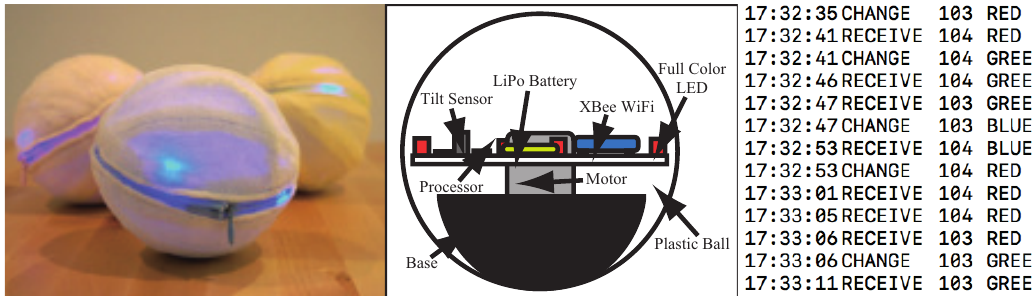
Figure 1. ( Left ) COLOLO: the spherical device to communicate presence, ( Center ) Hardware overview, ( Right ) Data collected by